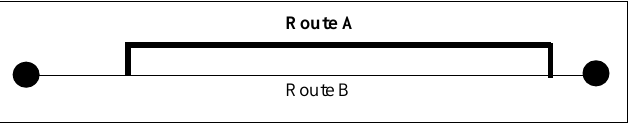
Figure 2: Optimal Route Selection by GIS using Djikstra's